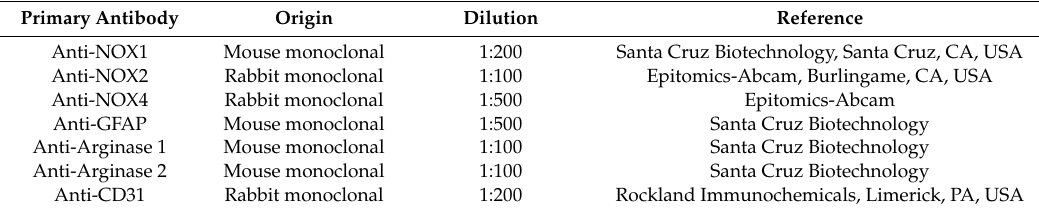
Table 2. Antibodies used for immunofluorescence studies.